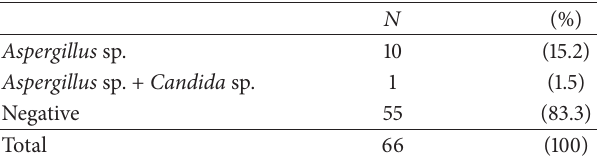
Table 1: Chief complaint.